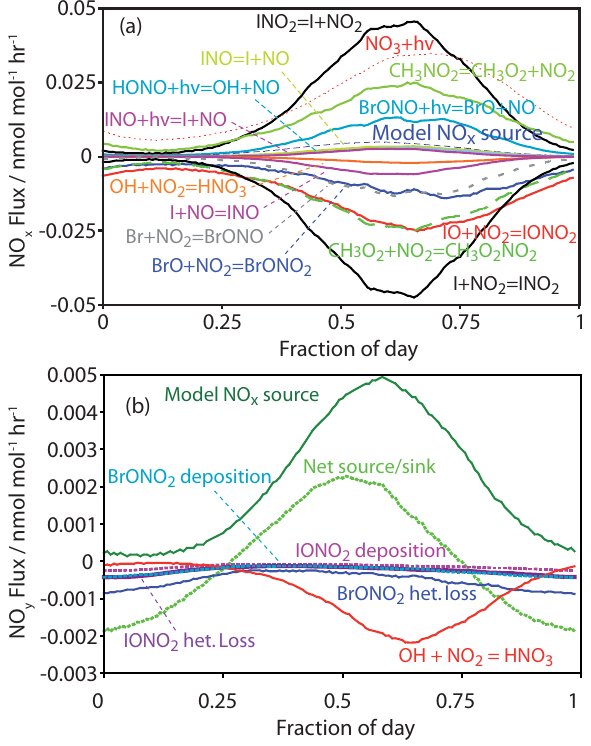
Fig. 5. Diurnal variation in modelled production and loss for (a) NO x and (b) NO y . Panel (a), major source and sink processes for NO x (here defined strictly as NO x =NO+NO 2 only) for model case B2. The NO 3 contribution (red dashed line) arises here from photolysis of IONO 2 and BrONO 2 , offsetting their sink role, rather than NO 2 +O 3 reactions. Panel (b), major source and sink contributions to NO y calculated for model sce- nario B2, plus net NO y production/removal (dashed line). NO y defined as NO y =NO+NO 2 +NO 3 +2N 2 O 5 +HONO+PNA+ CH 3 NO 3 +CH 3 O 2 NO 2 +XNO+XNO 2 +XNO 3 .